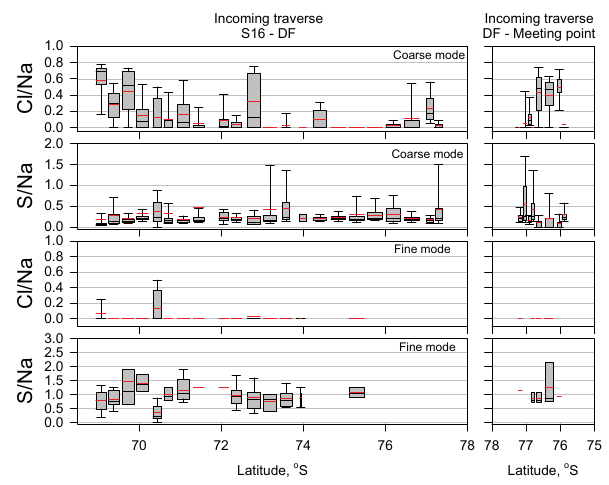
Figure 11. Horizontal features of atomic ratio of Cl/Na and S/Na in coarse and fine modes during the incoming traverse. In box plots, the top bar, top box line, black middle box line, bottom box line, and bottom bar respectively denote values of 90, 75, 50 (median), 25, and 10%. The red line shows mean values.